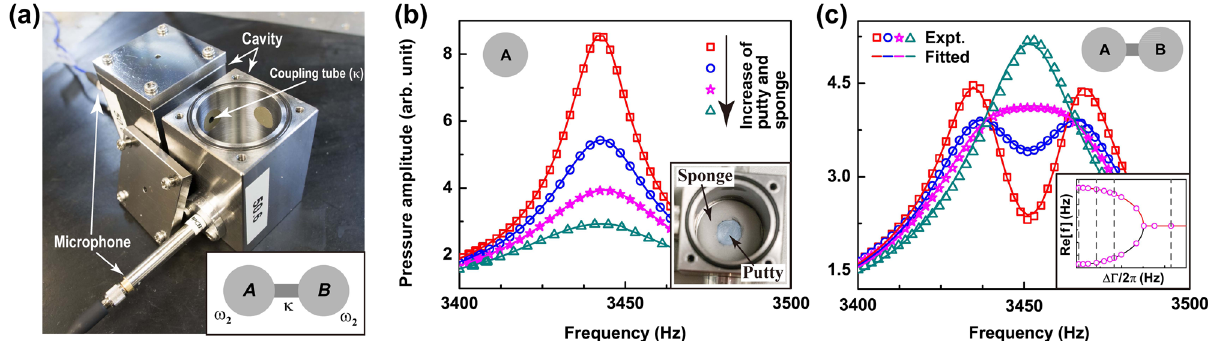
FIG. 1. (a) A photograph of two acoustic cavity resonators (labeled A and B in the inset) coupled by side tubes. Cavity B is opened and disconnected to show its interior and the coupling tubes. The inset is a schematic picture of the system. (b) Measured pressure responses as functions of frequency (symbols) of a single cavity ( h ¼ 50 . 6 mm) with increasing loss. The inset in (b) shows the arrangement of sponge and putty which is stuck to the bottom of the metallic cavity, and the amount of them is controlled by their mass. (c) Measured pressure response spectra (symbols) of the two coupled cavities. Cavities A and B have the same depth, h ¼ 50 . 6 mm. Coupling κ is achieved using two side tubes with radii of 2.0 and 0.8 mm, respectively. Asymmetric loss is introduced in cavity B , whereas both pumping and measurements are performed at cavity A . Solid curves in (b) and (c) are numerical fittings using a Green function method [Eq. (3)]. The inset in (c) shows fitted results of real parts of eigenfrequencies as a function of asymmetric loss ΔΓ . The vertical dashed lines in the inset correspond to the four ΔΓ shown in (c). The formation of an exceptional point at which the two states coalesce can be clearly